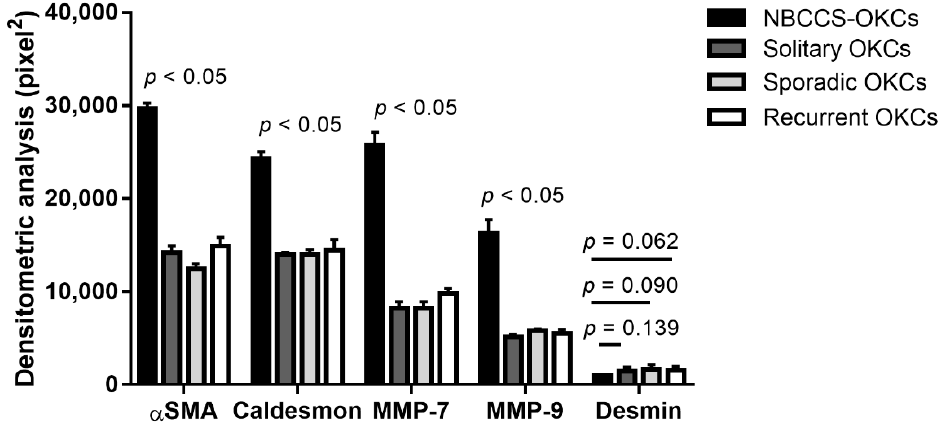
Figure 5. Densitometric analysis. A bar chart represents the comparison of the densitometric count (pixel2) of α SMA, caldesmon, MMP-7, MMP-9, and desmin immunostaining in the evaluated fields for NBCCS-OKCs tissue compared to solitary, sporadic and recurrent OKCs tissue, expressed by positive percentage, dark brown pixels of the analyzed fields. Data are presented as mean ± standard deviation (SD).